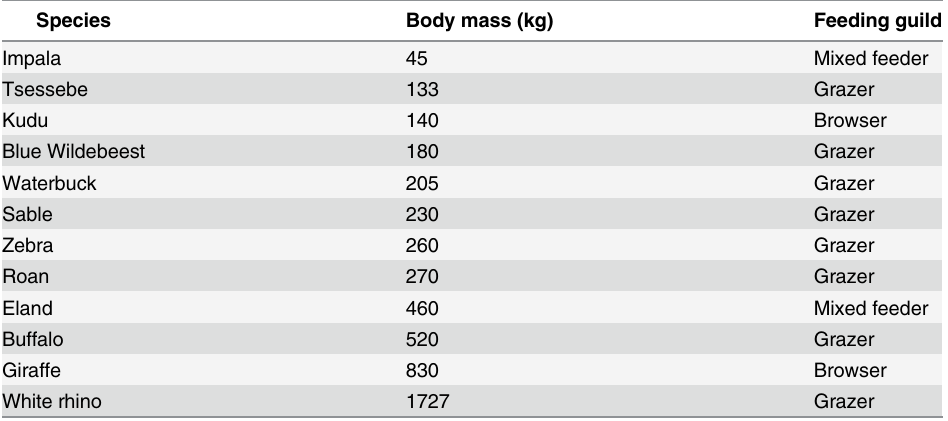
Table 1. Average adult body mass of herbivore species included in analysis (body mass from [56,57]) (arranged from smallest to largest). Species Body mass (kg) Feeding